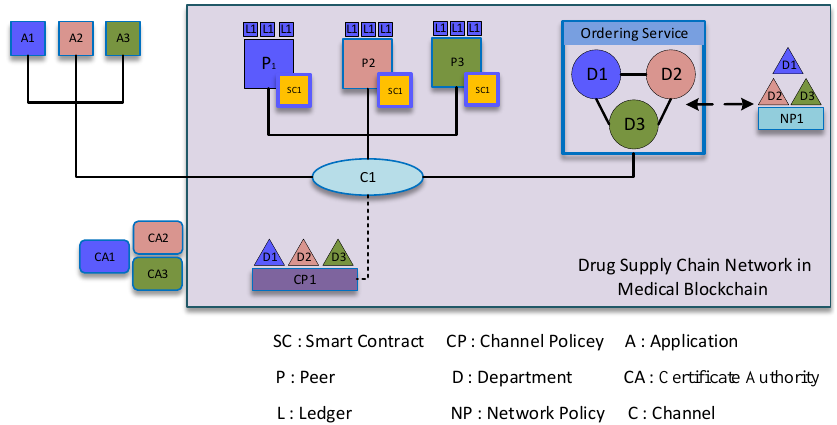
Figure 8. Network topology for drug supply chain management based on Hyperledger Fabric in a medical blockchain